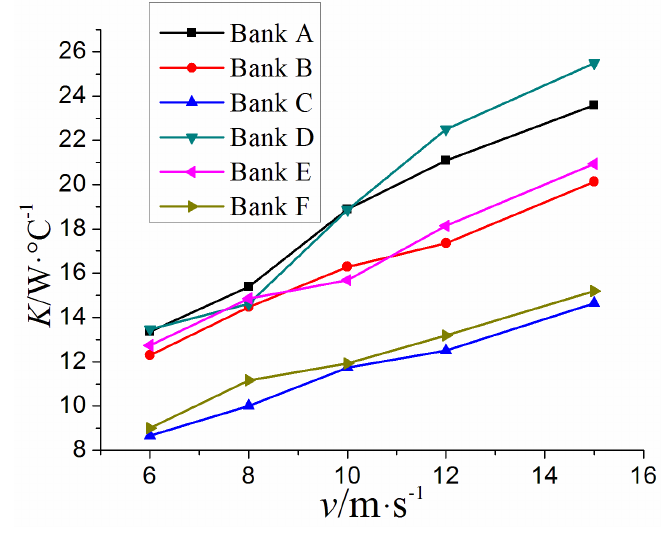
Figure 6. The relationship between integrated heat transfer capacity K and air velocity v.